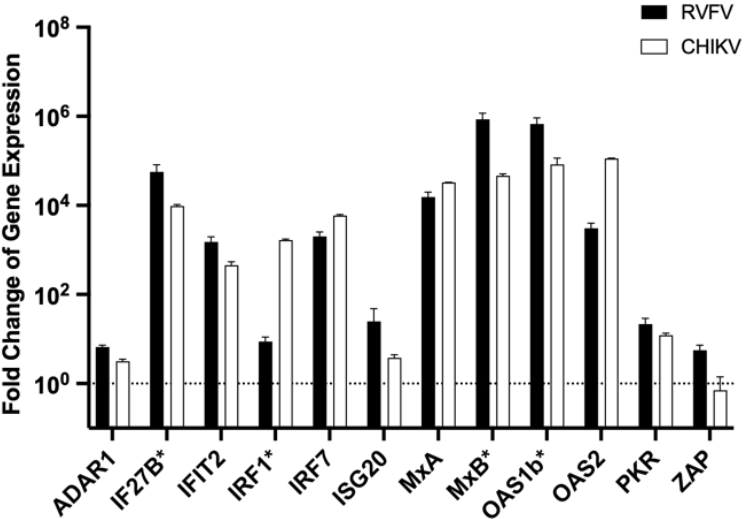
Figure 3. Changes in M Φ ISG expression after infection with RVFV or CHIKV. M Φ s were infected with either RVFV or CHIKV with an MOI of 1 and incubated for 24 h. RNA was isolated and depleted of DNA. For the RT-PCR-based assays, 10 ng of overall extracted RNA was used. Normalisation was performed with the ∆∆ Ct method with the housekeeping gene Ppil4. Genes were marked with an asterisk (*) if no signal Ct value for the controls was obtained due to too low concentrations in uninfected cells. The previously determined cut-off Ct values (Table 2) were used to calculate the fold change of ISG expression of these genes. The dashed line indicates the normal ISG level of untreated control cells. The experiment was performed in triplicate. Shown are the mean and standard deviation.